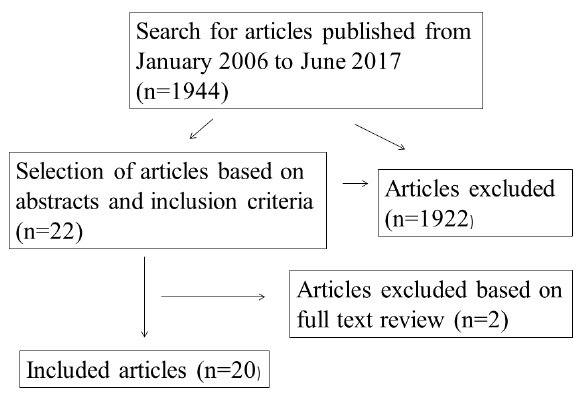
Figure 1. Flow chart for inclusion of studies.